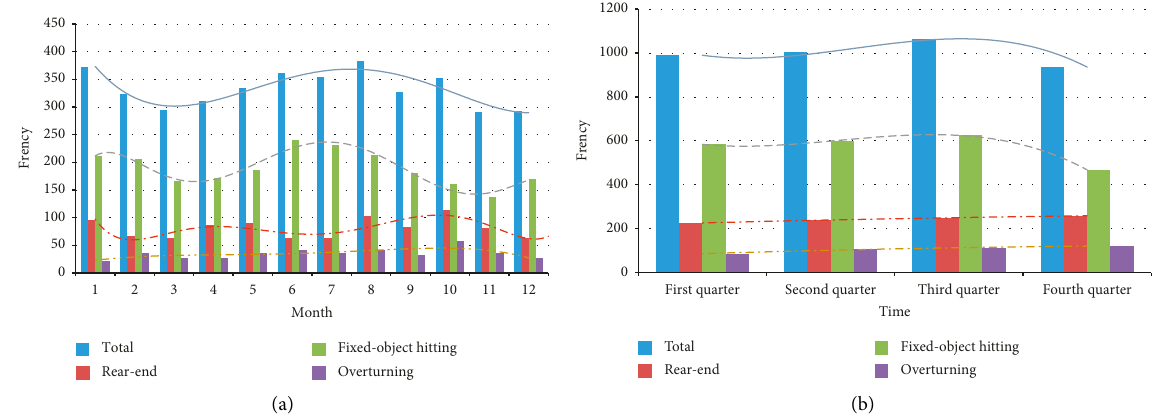
Figure 1: Temporal distribution of crashes: (a) crash type distribution by month and (b) crash type distribution by quarter.